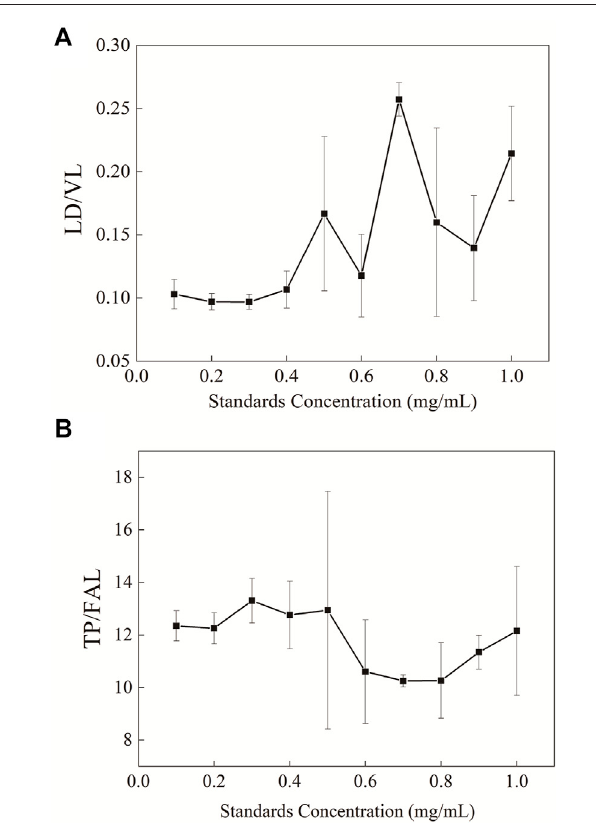
FIGURE 6 | Changes in the ratio of peptide in the samples with different protein concentrations after enzymolysis (A) LD/VL and (B) TP/FAL.